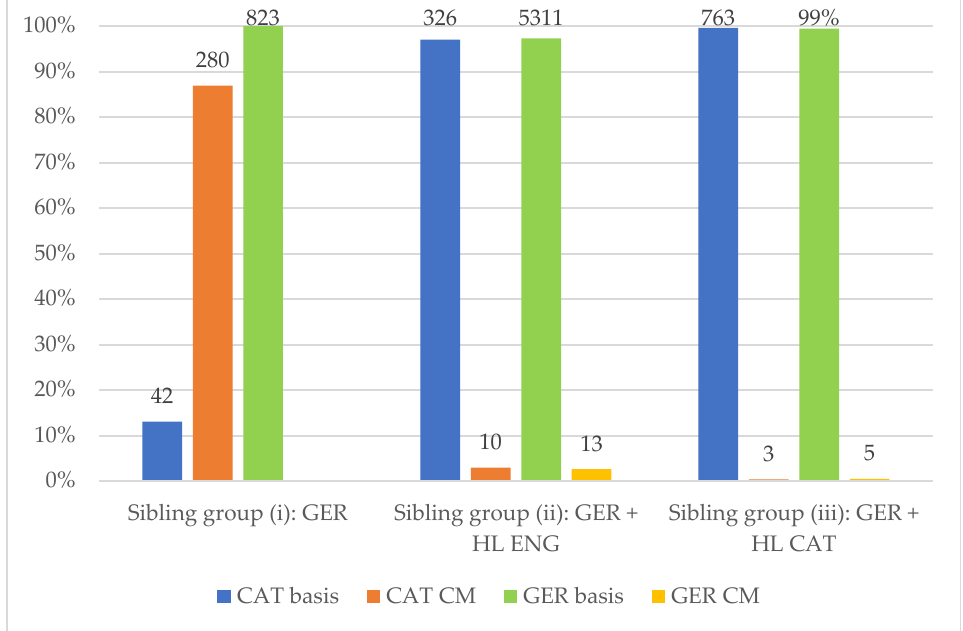
Figure 15. Catalan and German basis and CS depending on reported language use among siblings.